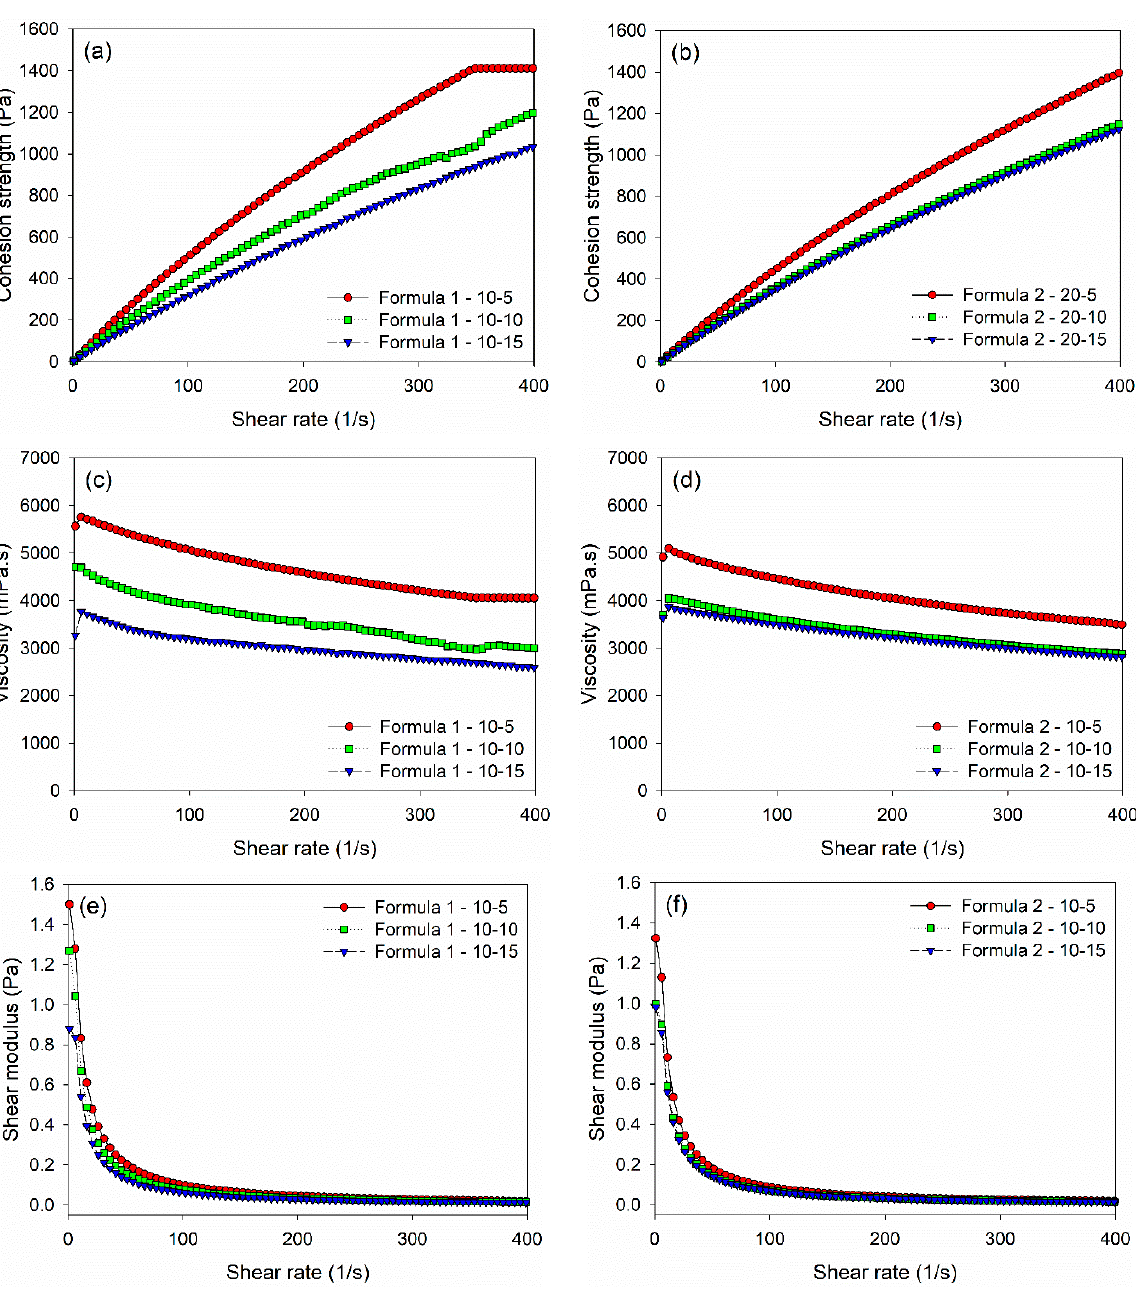
Figure 3. Flow behavior analysis of PVOH–tannin–hexamine-based adhesives. ( a ) Cohesion strength of Formula 1, ( b ) cohesion strength of Formula 2, ( c ) dynamic viscosity of Formula 1, ( d ) dynamic viscosity of Formula 2, ( e ) shear modulus of Formula 1, ( f ) shear modulus of Formula 2.